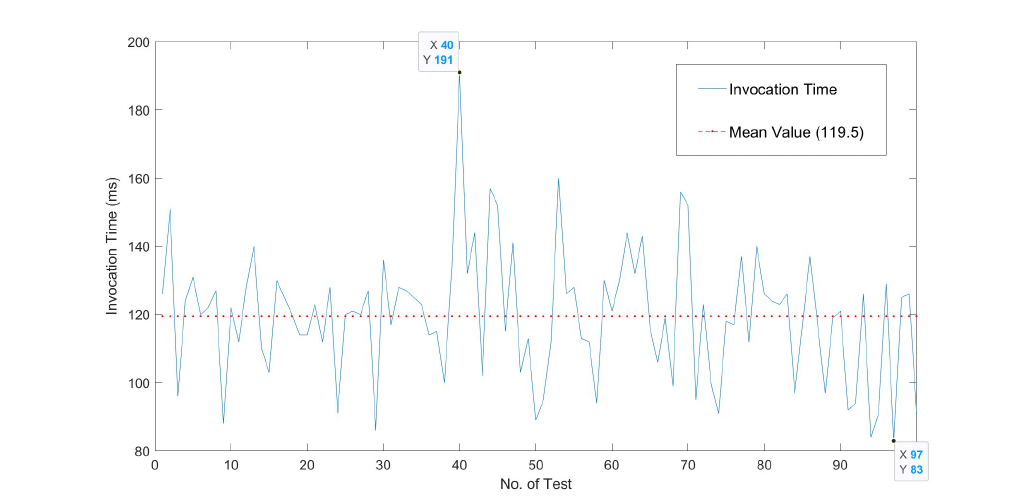
Figure 7. Execution time of login function.